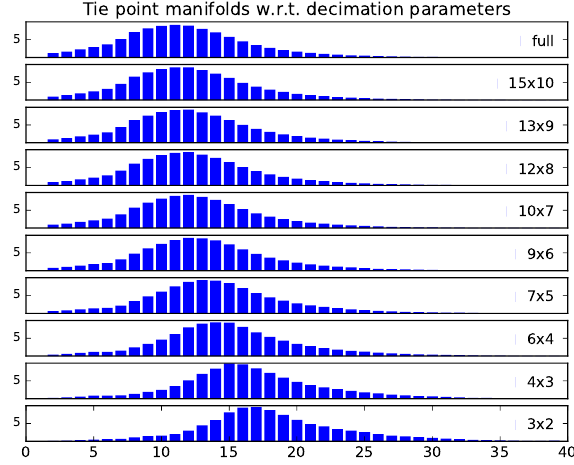
Figure 2: Histograms of tie point manifolds [%] at different dec- imation grid resolutions. Top: tie points exported from Pix4D. Bottom: tie points decimated on an image grid overlay with 3 columns and 2 rows. During each decimation process, the target count of tie points per image grid cell to retain is set to 1.